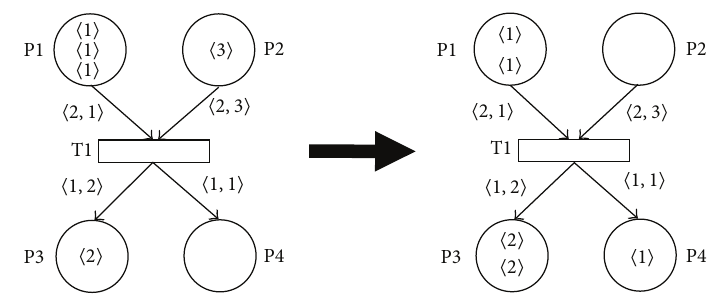
Figure 1: Firing of transition in SNT Petri net 𝑁1.